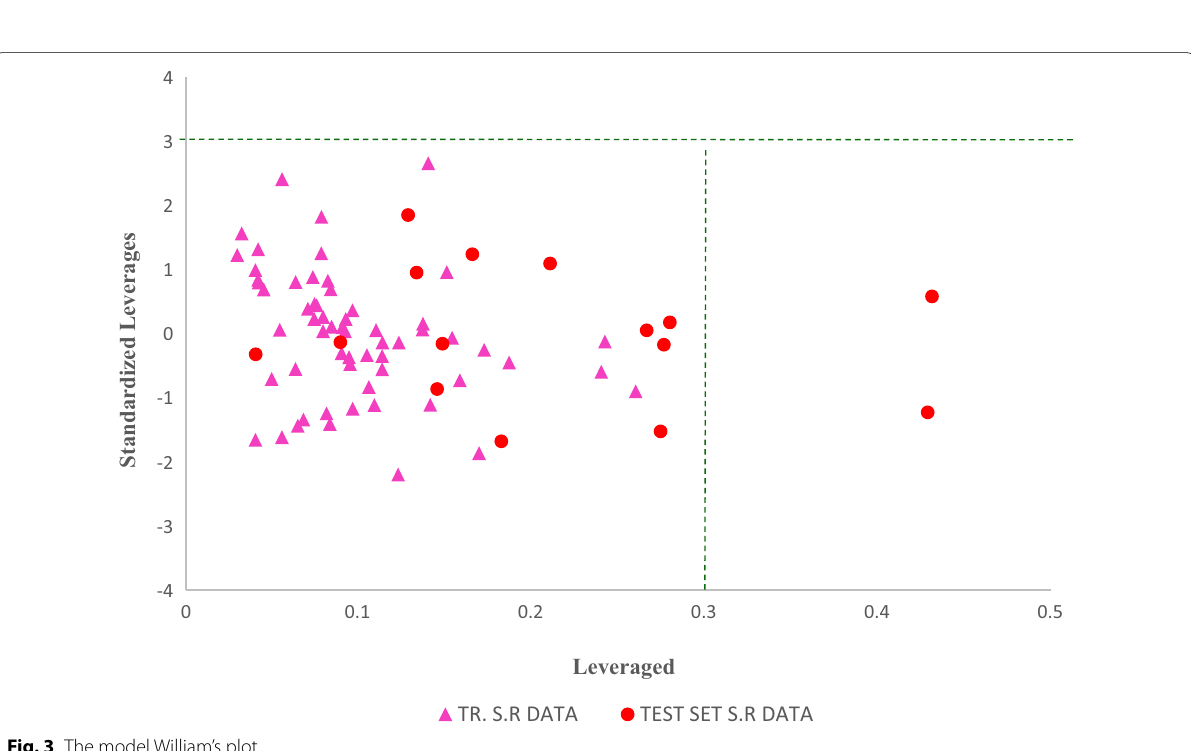
Fig. 3 The model William’s